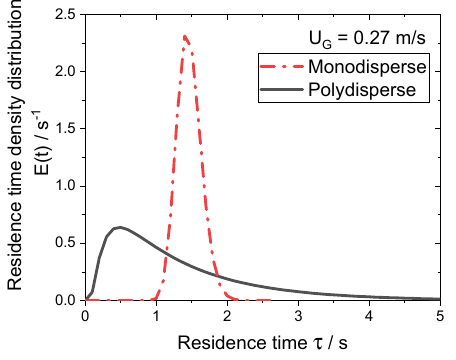
Figure 9. Numerical particle residence time density distributions under U G = 0.27 m/s for different particle sizes (Polydisperse: Volumetric particle size distribution according to Figure 4; Monodisperse: Sauter diameter of the particle size distribution displayed in Figure 4).